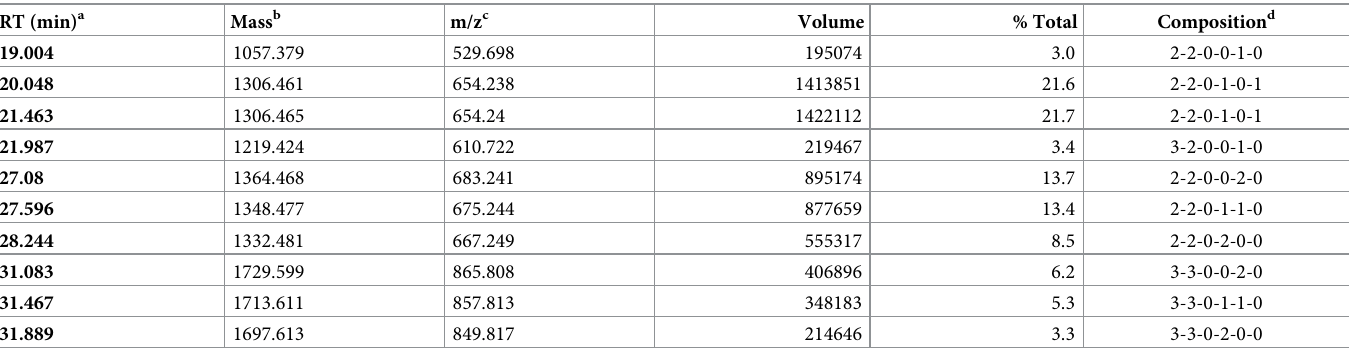
Table 5. Identification by mass spectrometry of O-glycans released from rat platelet GPIb α . RT (min)